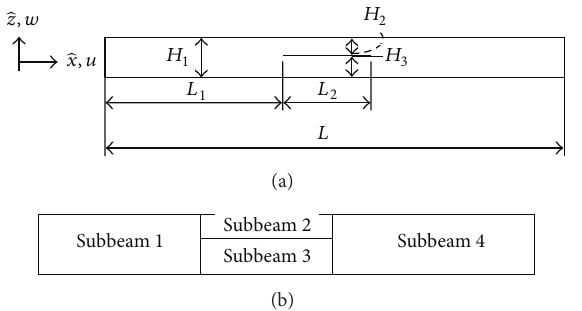
Figure 2: Sign convention for bending moment M and shear force